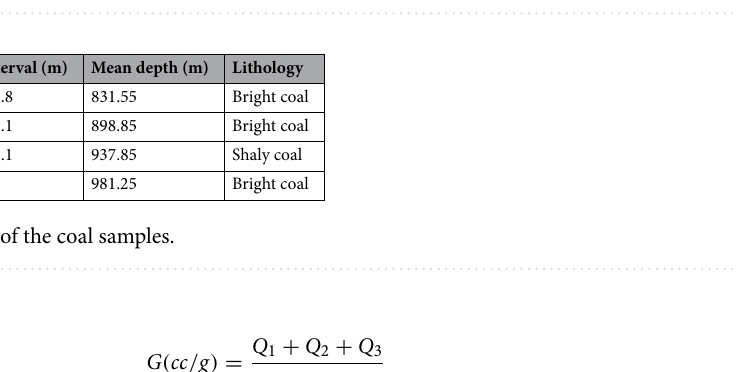
Figure 1. Location of coal samples in Jharia coalfield (Modified after Panigrahy et. al, 2015 29 and plotted using Golden Software Surfer 11.0.642).